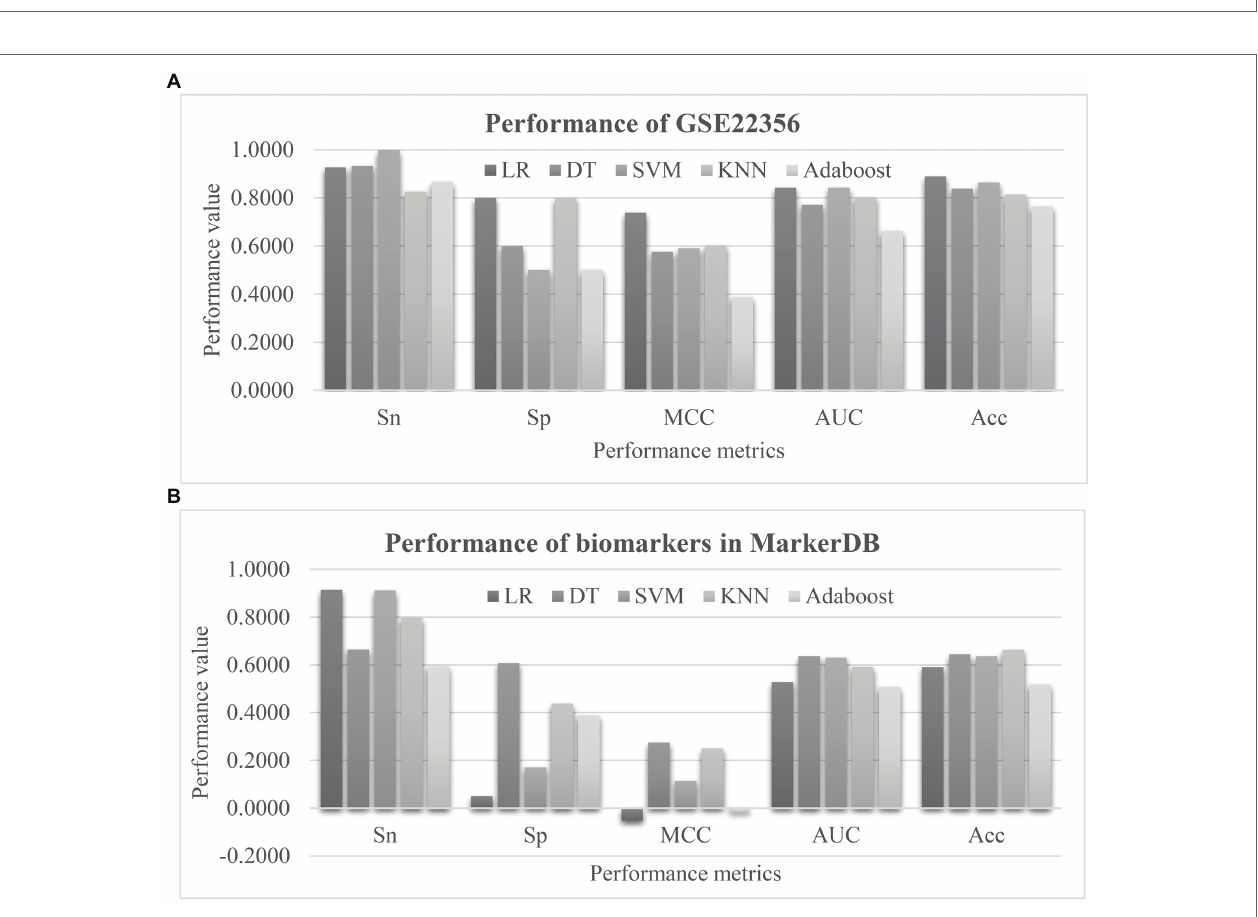
FIGURE 8 | Evaluation of the pulmonary hypertension (PH) detection model. (A) Validation of the 50 EnRank-recommended PH biomarkers in the dataset GSE22356. (B) Performances of the existing PH biomarkers. The horizontal axis listed the performance metrics Sn/Sp/MCC/ROC/Acc and the five classifiers were given as data series. The vertical axis gave the values of the performance